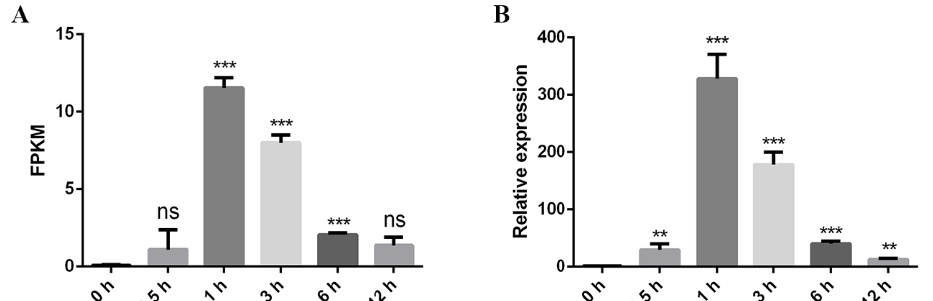
Figure 2. Expression of LlERF110 under heat stress at different times. ( A ) RNA-seq data showing the expression of LlERF110 under the 37 ◦ C treatment at 0 h, 0.5 h, 1 h, 3 h, 6 h, and 12 h. ( B ) The relative expression of LlERF110 was measured using qRT-PCR under the 37 ◦ C treatment at 0 h, 0.5 h, 1 h, 3 h, 6 h, and 12 h. 18S rRNA was used as a control. Three independent experiments were performed each with three technical replicates; the results of one experiment are shown. T -test analysis of variance was employed to identify treatment means that differed statistically. Samples with different stars are significantly different; ** p < 0.01 and *** p < 0.001; ns means non-significance.